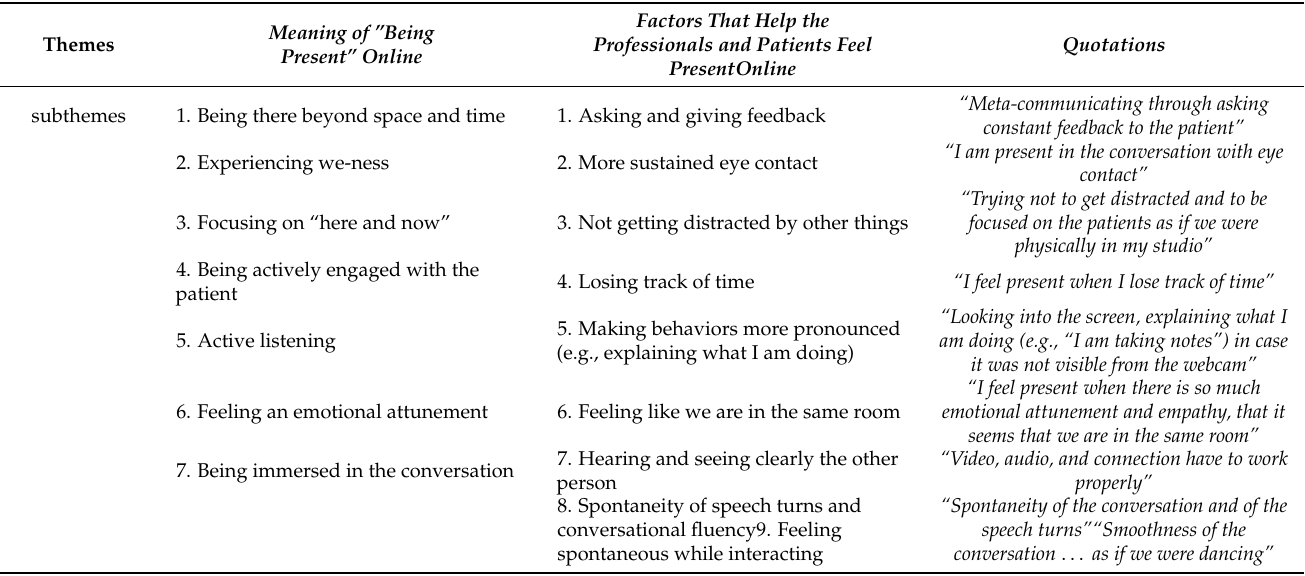
Table 9. Themes and subthemes identified analyzing the responses to the open-ended question regarding the meaning of “being present” in the online setting and the factors that help professionals and patients feel present in the online